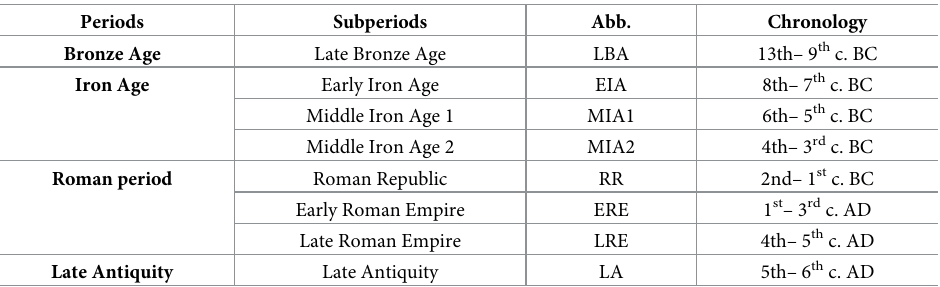
Table 1. Diachrony